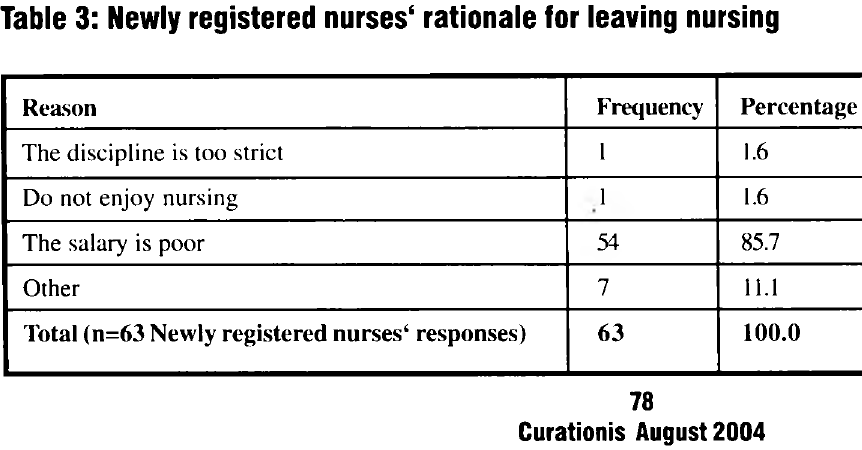
Table 3: Newly registered nurses1 rationale for leaving nursing Reason